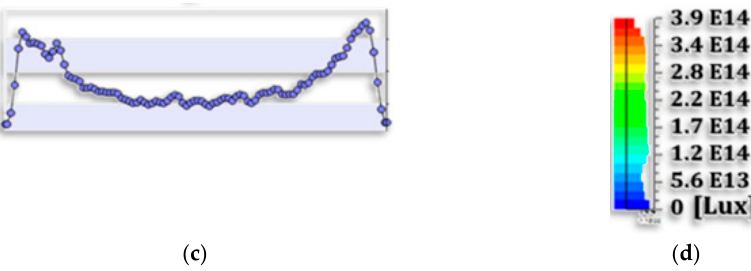
Figure 8. Outgoing Cone light spatial distribution obtained with LightTools software. ( a ) cone light; ( b ) y -axis distribution; ( c ) x -axis distribution; ( d ) colors Legend in Lux units.